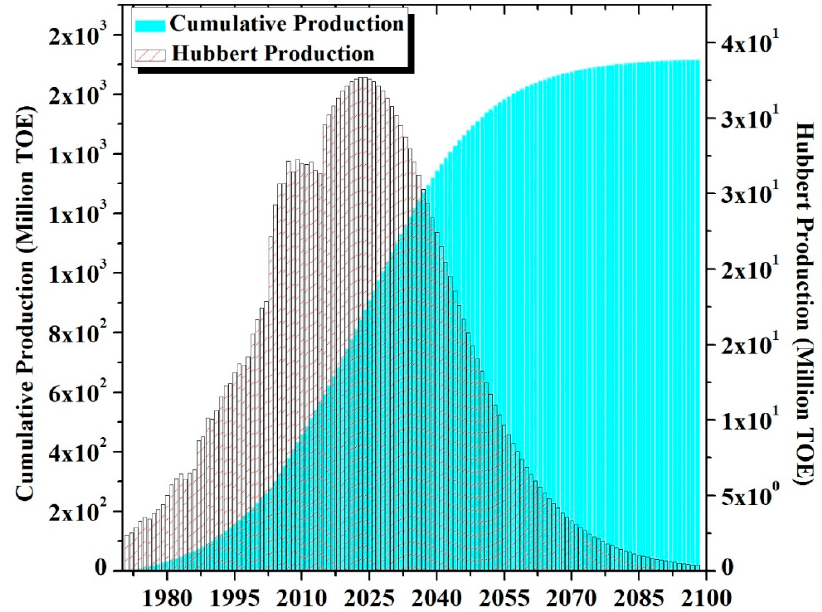
Figure 13. Hubbert and cumulative production peak for natural gas (Million toe).